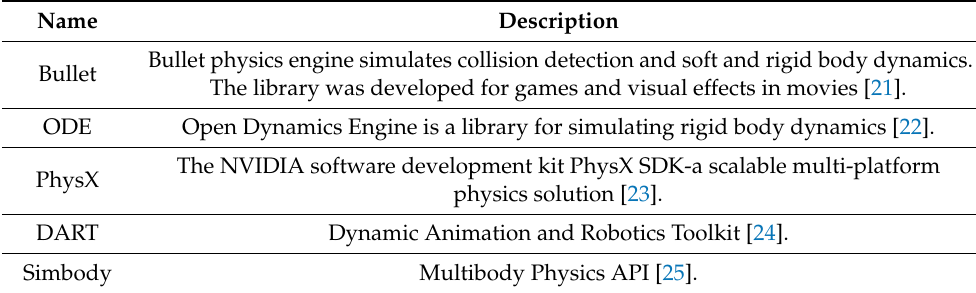
Table 3. Physics engine